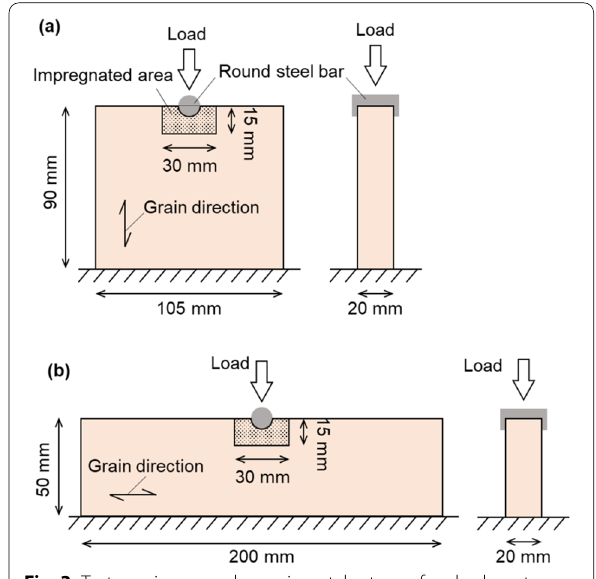
Fig. 3 Test specimens and experimental setups of embedment test. a Specimen loaded parallel to the grain. b Specimen loaded perpendicular to the grain